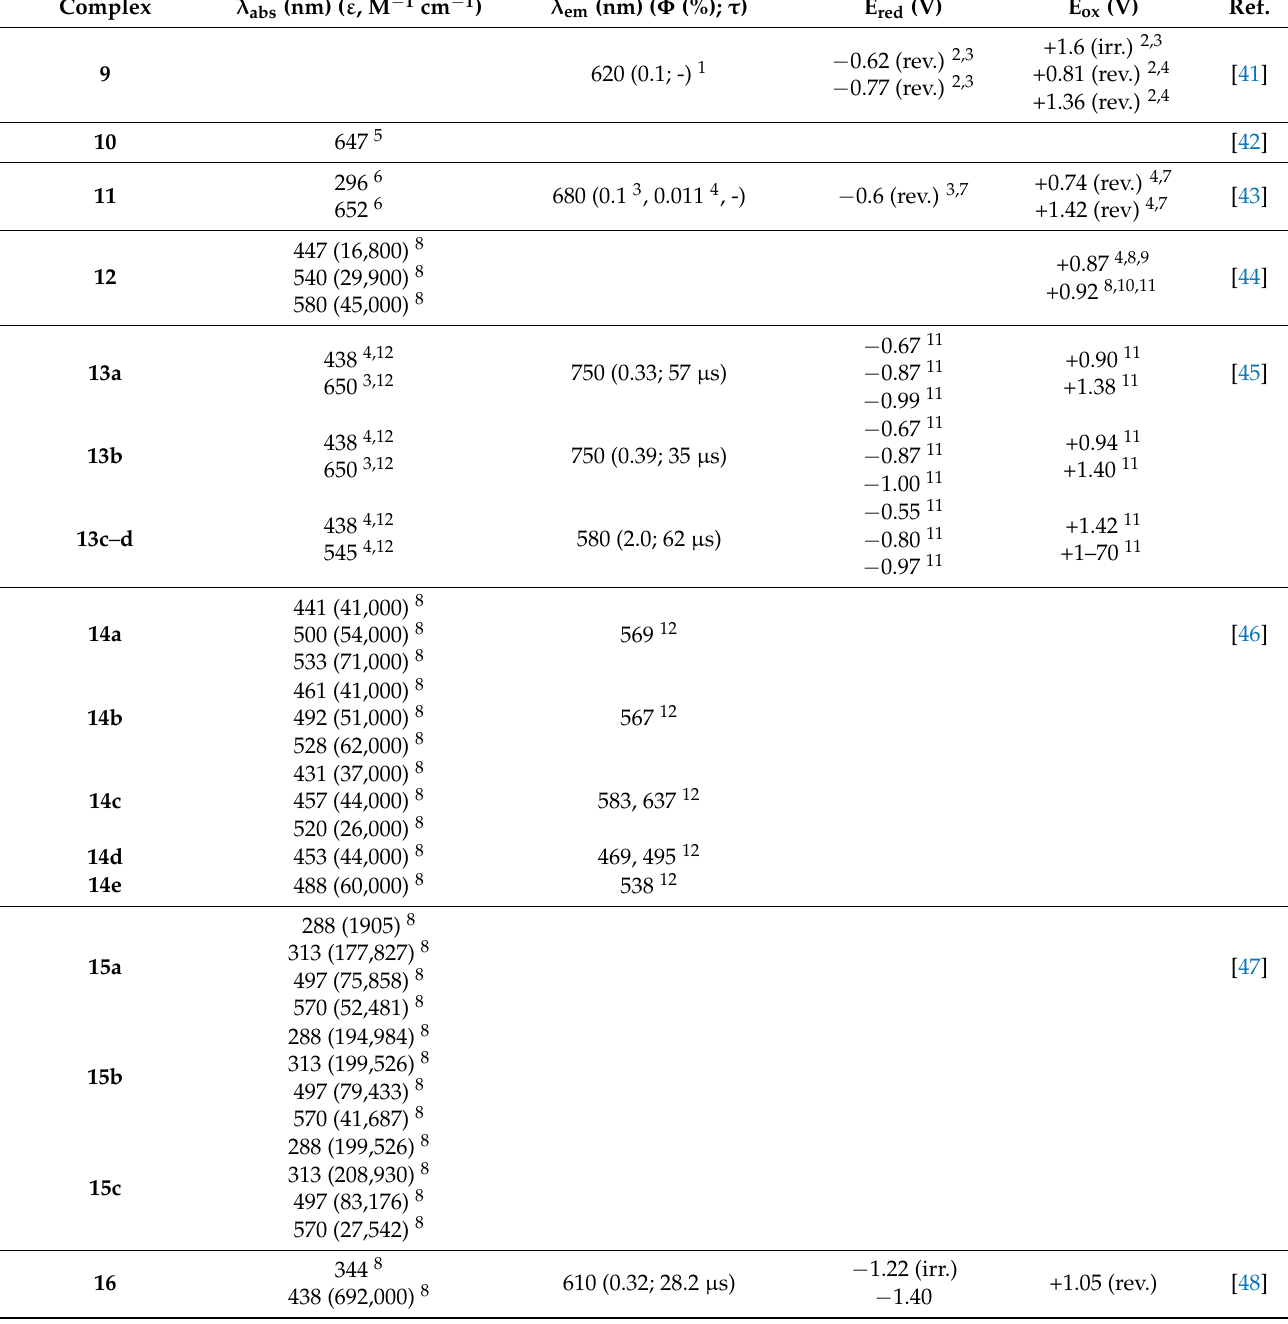
Table 2. Photophysical and redox properties of complexes 9 , 10 , 11 , 12 , 13a – d , 14a – e , 15a – c , and 16